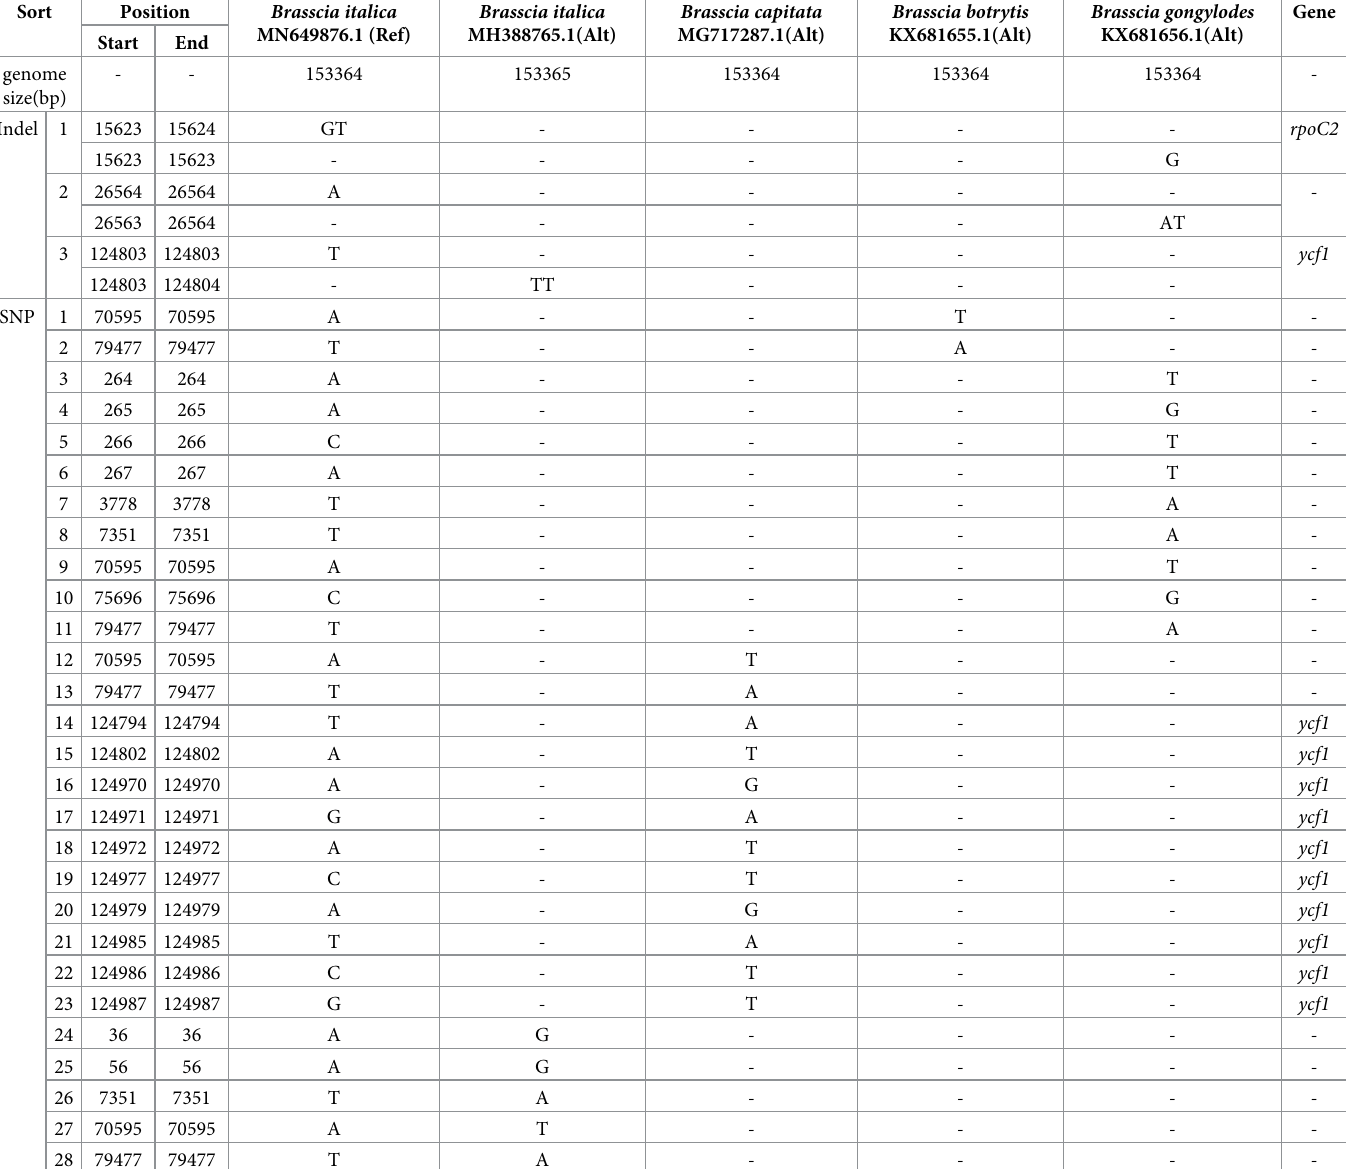
Table 5. Differences in genome size and genome divergence (SNPs and Indels) between the newly generated genome (MN649876.1) and other Brassica oleracea genomes. Sort